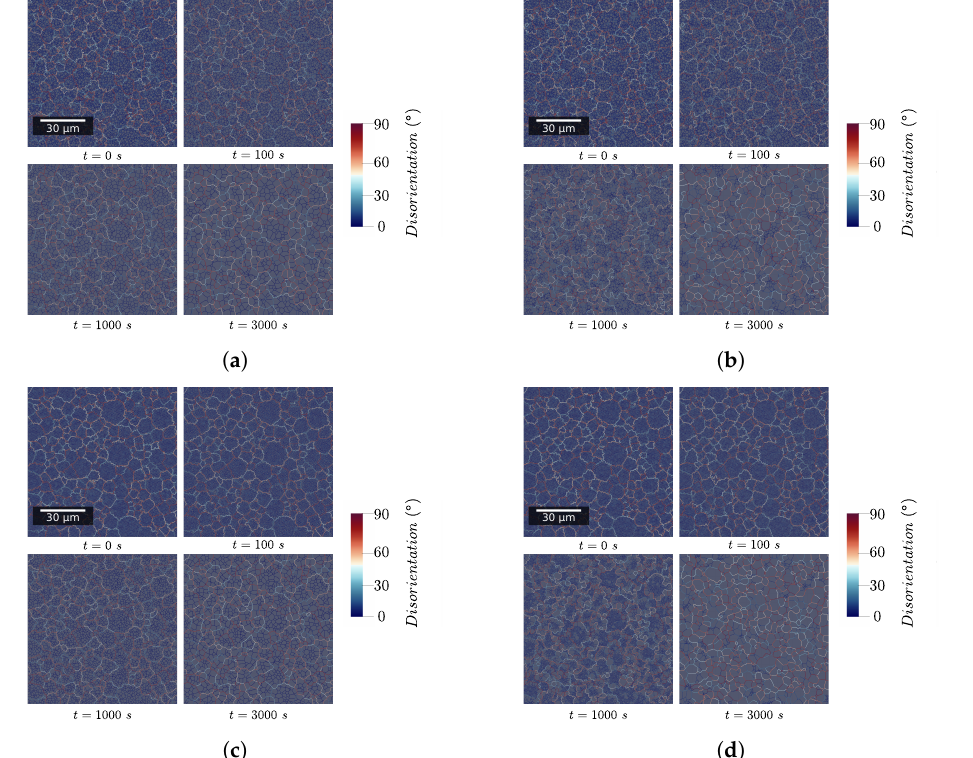
Figure A1. Evolution of GB network with time for the four test cases. ( a ) Experimental subgrain size distribution— γ h . ( b ) Experimental subgrain size distribution— γ h , M h . ( c ) Uniform subgrain size distribution— γ h . ( d ) Uniform subgrain size distribution— γ h , M h